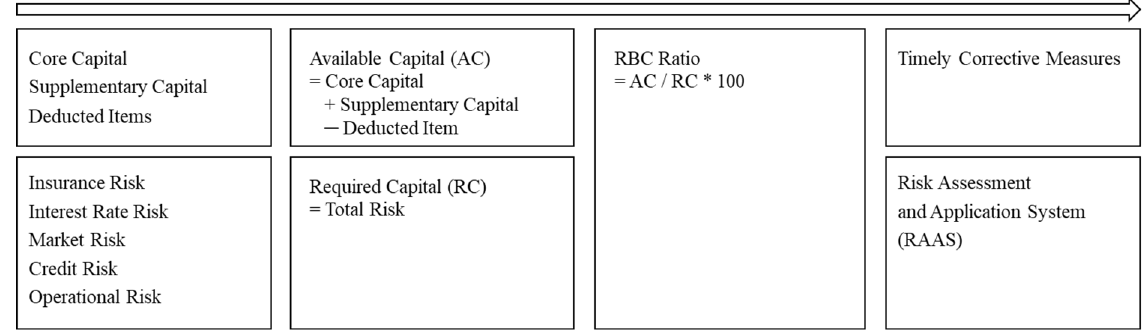
Figure 1. Calculating RBC ratio. Source: Financial Supervisory Service (2017).